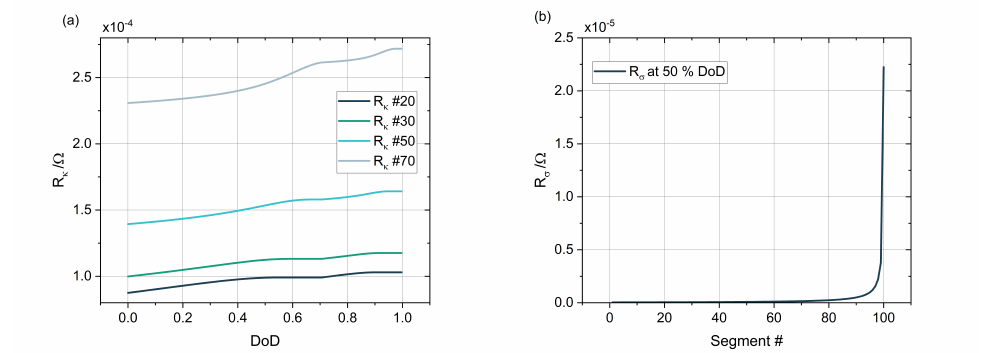
Figure 6. ( a ) Resistance due to ion transport over DoD. ( b ) Electrical resistance in the solid metal matrix over segment number, for DoD = 0.5. Both graphs have been modelled for discharging with 1/8 C